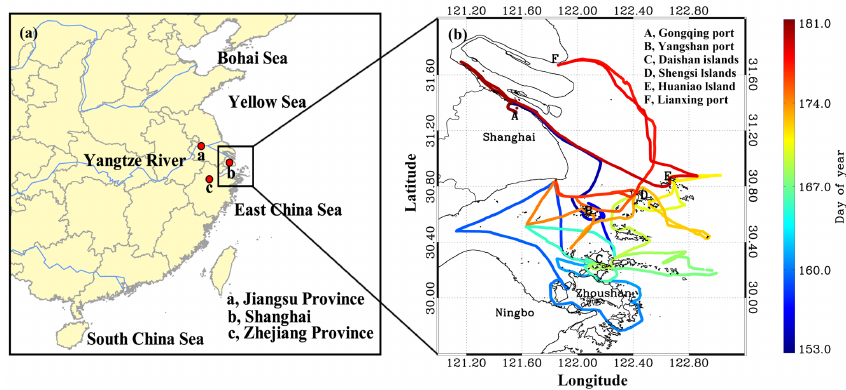
Figure 1. Location (a) and cruise routes (b) of the ship-based campaign from 2 to 29 June 2017 (DOY 153 to 181).